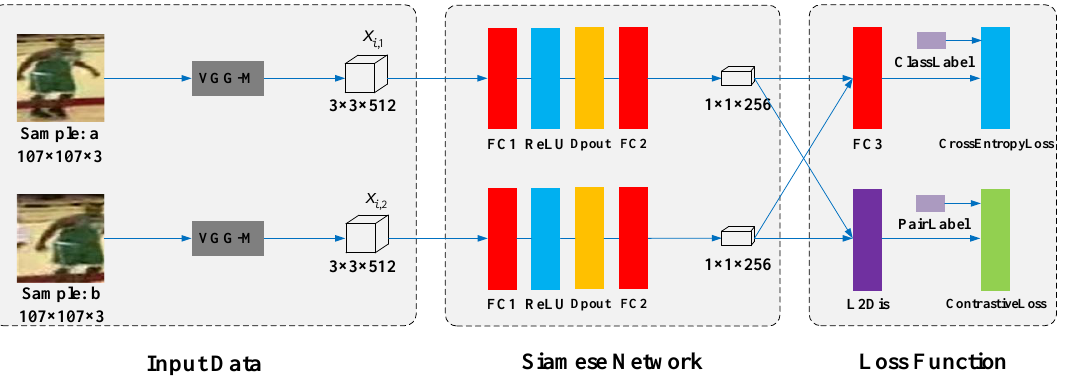
Figure 1. The framework of Siamese Network in OSNV. Left : Input Data for updating Siamese network , which are the outputs of layer conv3 in VGG-M. Our proposed Siamese network lies in the middle, and two groups of branches share the same configuration and weights. Right : the improved contrastive loss, which is served as the Loss Function to propagate gradients for updating the Siamese network . Dpout stands for drop-out layer, best viewed in